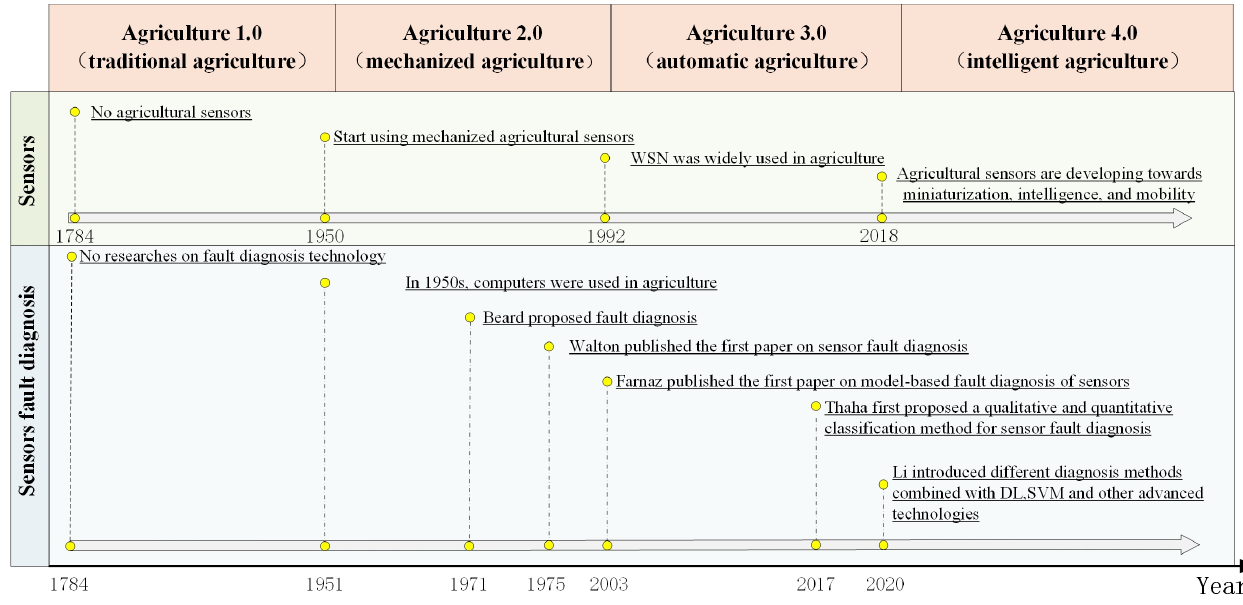
Figure 1. Timeline of development in sensor fault diagnosis technology in Ag ‐ IoT systems.